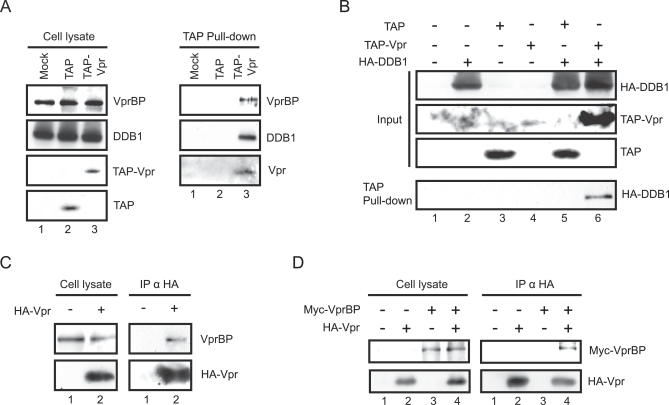
Immunoprecipitation of DDB1/Vpr and VPRBP/Vpr Complexes(A) HEK293T cells were mock transfected (lanes 1) or transfected with either TAP (lanes 2) or TAP-Vpr–expressing plasmids (lanes 3). Two days later, immunoprecipitations of TAP tag were performed on cell lysates using IgG-coupled beads and purified complexes were eluted by cleavage with TEV protease. The levels of endogenous VPRBP and DDB1 were monitored in crude lysates and pulled-down fractions by Western blot using specific antibodies. TAP, TAP-Vpr, and cleaved Vpr were detected using a polyclonal rabbit antibody directed against a Vpr N-terminal peptide.(B) HEK293T cells were mock transfected (lanes 1 and 2) or transfected with either TAP (lanes 3 and 5) or TAP-Vpr–expressing plasmids (lanes 4 and 6). Cells were transcomplemented with the empty vector (lanes 1, 3, and 4) or HA-DDB1–encoding plasmid (lanes 2, 5, and 6).(C) HEK293T cells were mock transfected (lanes 1) or transfected with HA-Vpr–expressing plasmid (lanes 2). Immunoprecipitations using anti-HA antibodies were performed on cell extracts using protein A–sepharose beads. The levels of HA-Vpr and endogenous VPRBP were monitored in cell extracts as well as immunoprecipitated fractions by Western blot using specific antibodies.(D) HEK293T cells were mock transfected (lanes 1 and 3) or transfected with a HA-Vpr–expressing plasmid (lanes 2 and 4). Cells were transcomplemented with the empty vector (lanes 1 and 2) or Myc-VPRBP–encoding plasmid (lanes 3 and 4). Anti-HA immunoprecipitations were performed as described above.